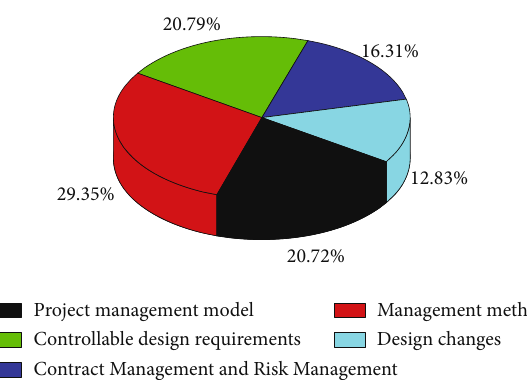
Figure 4: The proportion of major accidents caused by construction project management level in the past ten